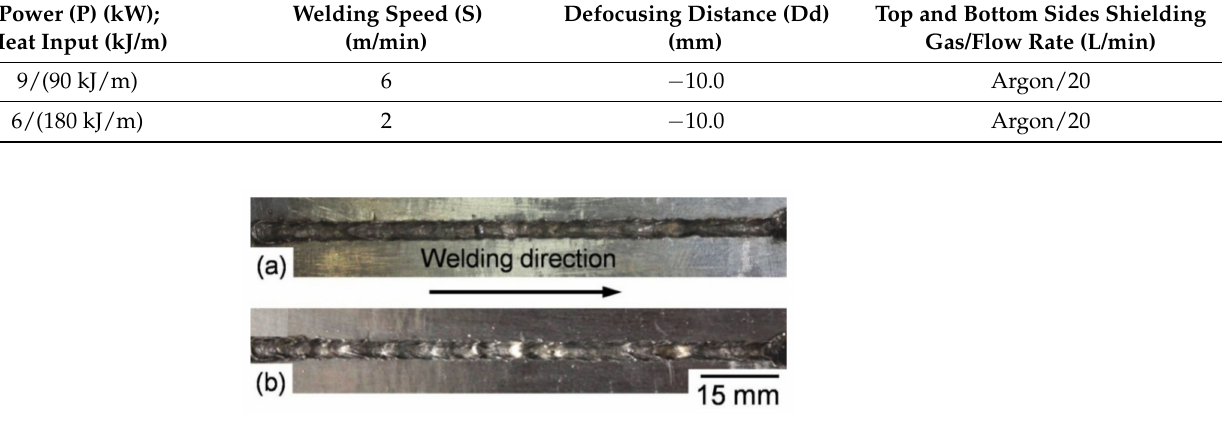
Figure 3. Weld bead surface images of the face side of laser butt-welded joints obtained using the low ( a ) and high ( b ) heat